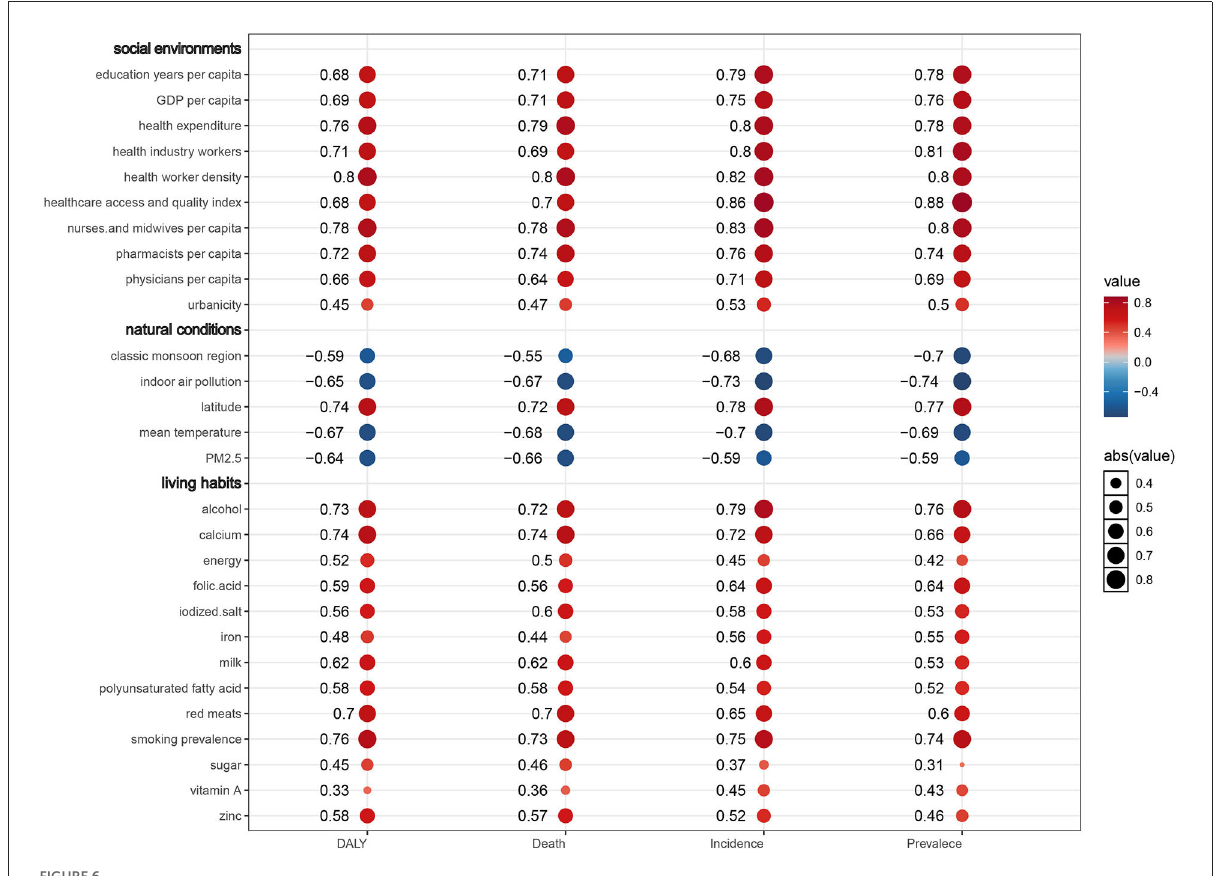
FIGURE6 Covariates of CAVD. CAVD, calcific aortic valve